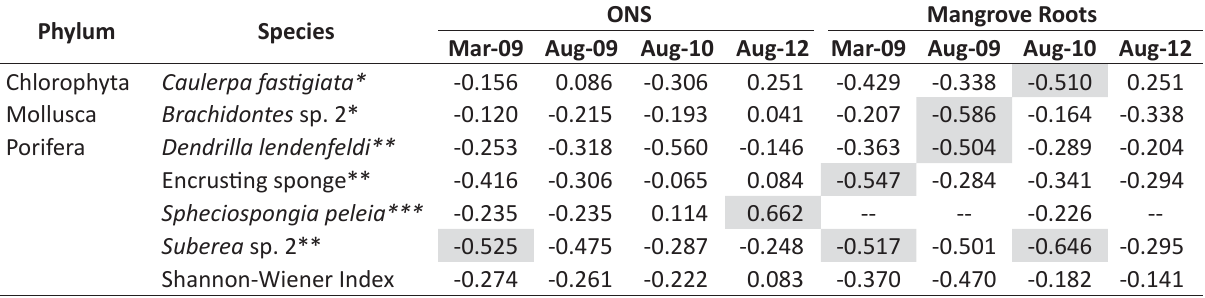
Table 2. Spearman rho values for correlations between Exaiptasia pallida (predictor variable) and percent cover of a subset of native species with at least one significant association or Shannon–Wiener Index of native community (response variables) in Jellyfish Lake, calculated for two habitat categories: other near surface substrate (ONS) and mangrove roots. Correlations are given per survey (March and August 2009, August 2010, and August 2012) to permit visualization of temporal consistency or change in relationships. Predominant (*), common (**), and rare (***) species are marked with corresponding number of asterisks. Significant correlations with sequential Bonferroni correction (p < 0.1) are highlighted in grey. A mark of “—“ indicates that species were not found on that particular habitat during the